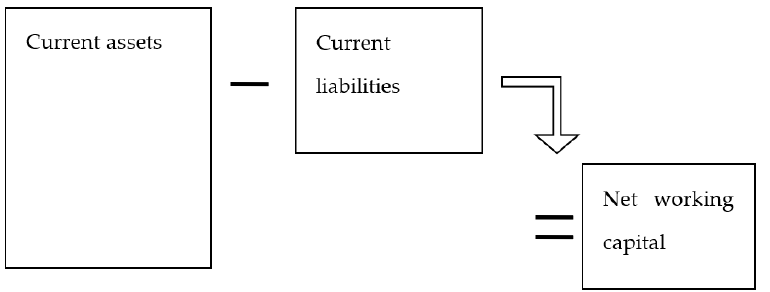
Figure 1. Net working capital on a balance-sheet basis. Source: own research. In long-term, i.e., capital terms, it is a surplus of fixed capital (FC) over fixed assets (FS). The fixed capital is the sum of equity capital (EC) and long-term liabilities (LL). The net working capital calculated on a long-term basis is shown in Figure 2.